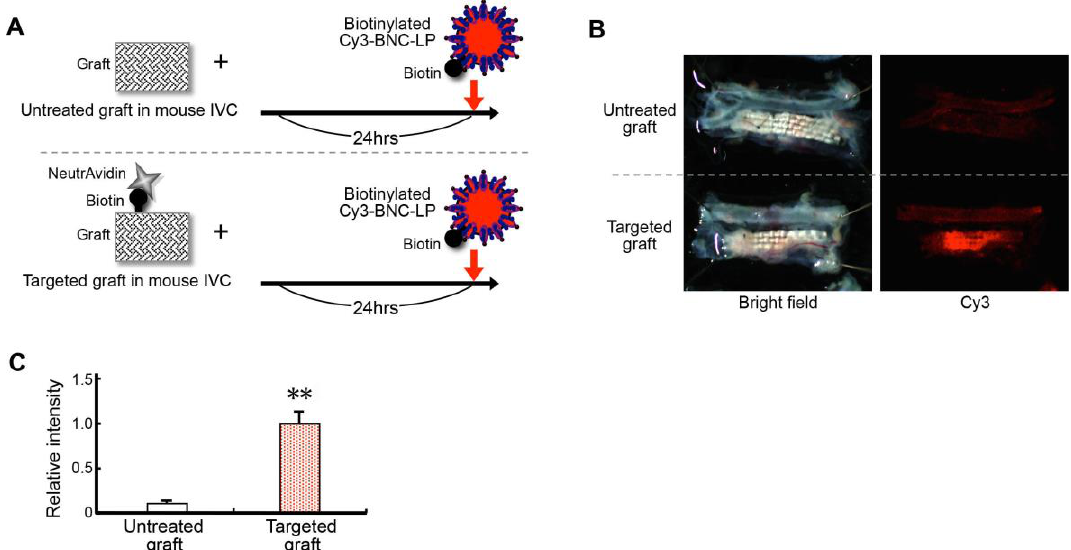
Figure 6. Efficient charging of the targeted graft with the target-recognizing BNC-LP complex in vivo. ( A ) Schematic diagram of the experiment: the targeted graft is compared to the untreated control graft. ( B , left) Bright field images show the grafts excised from mice after the experiment. (Right) Fluorescence images show the accumulation of Cy3-labeled BNC-LP on the targeted graft. ( C ) Efficiency of charging the targeted graft with the BNC-LP complex, determined by measuring the relative fluorescence intensity. Data are the means ± standard deviations of 3 independent observations. ** p < 0.01 compared to the untreated graft.